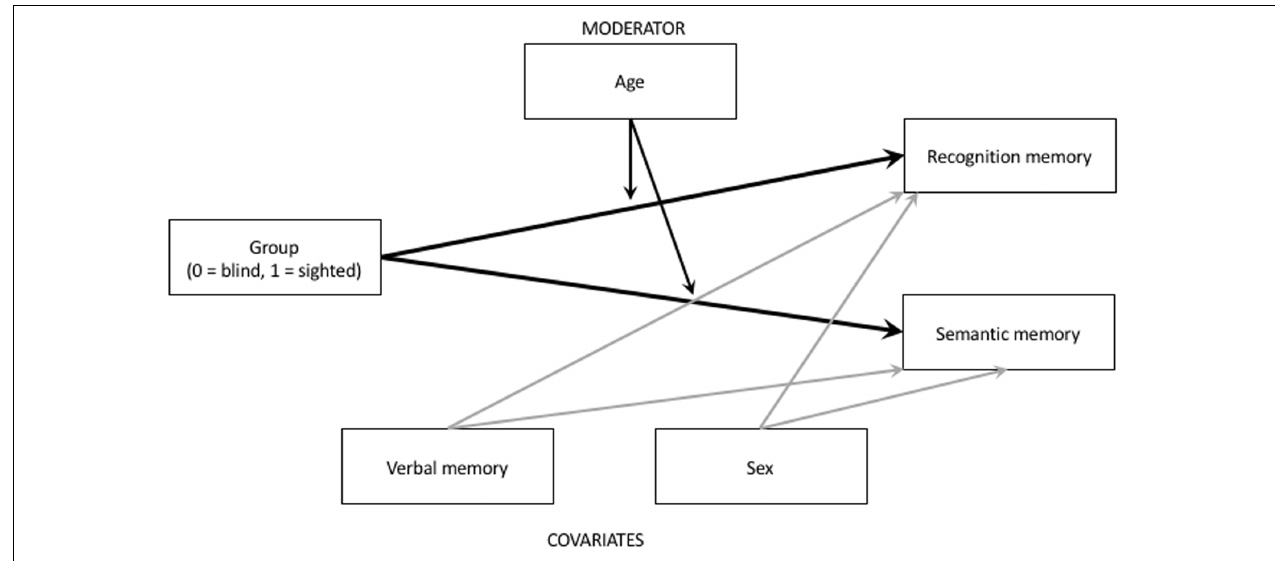
FIGURE 1 | Illustration of the analyzed